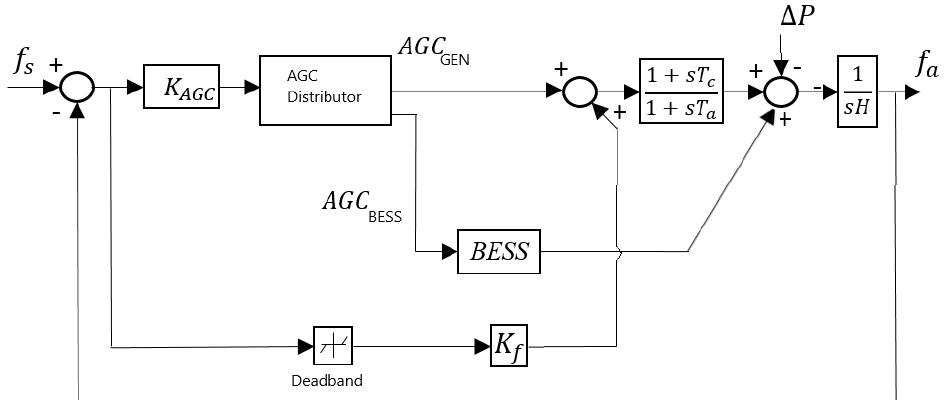
Figure 2. BESS operation